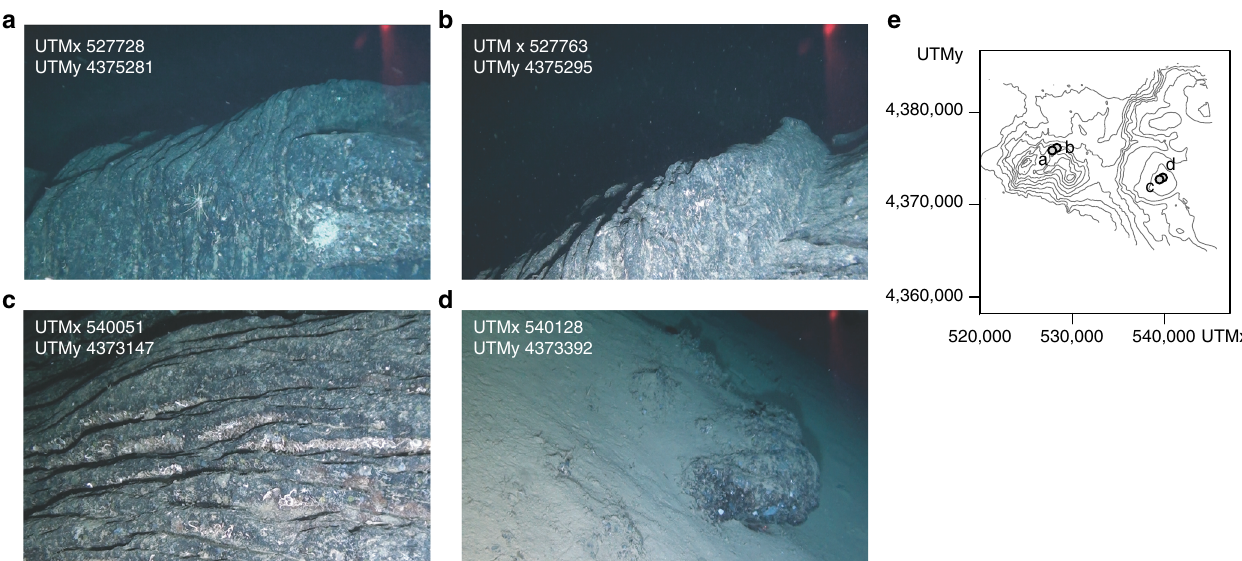
Fig. 4 Images of the sea fl oor acquired with ROV. a Surface of a sheet lava fl ows. b Sub-vertical dike of the Enotrio Seamount. c Surface of a sheet lava fl ow and, d lava blob (pillow) of the fl at-top edi fi ce 12 (Fig. 2 for location). The UTM coordinates of the images and their map location ( e ) are also reported